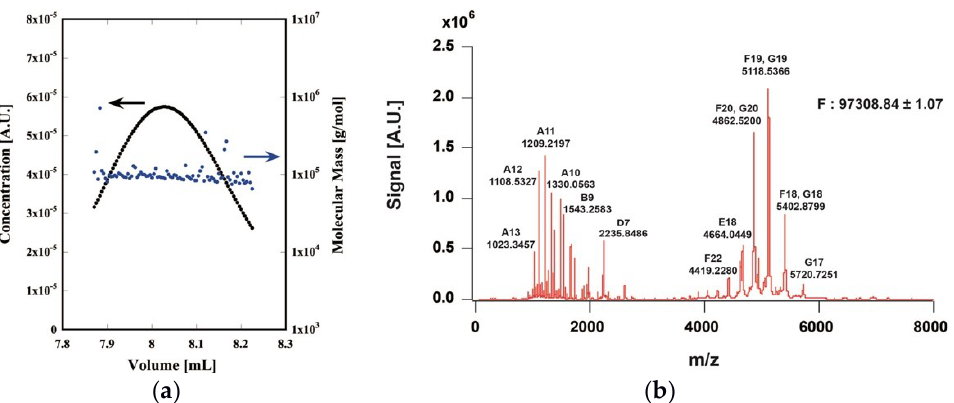
Figure 3. Molecular mass determination of CtPFD. ( a ) SEC-MALS of purified CtPFD. Black, protein concentration (arbitrary units); Blue, molecular mass. ( b ) Native mass spectrometry of CtPFD.